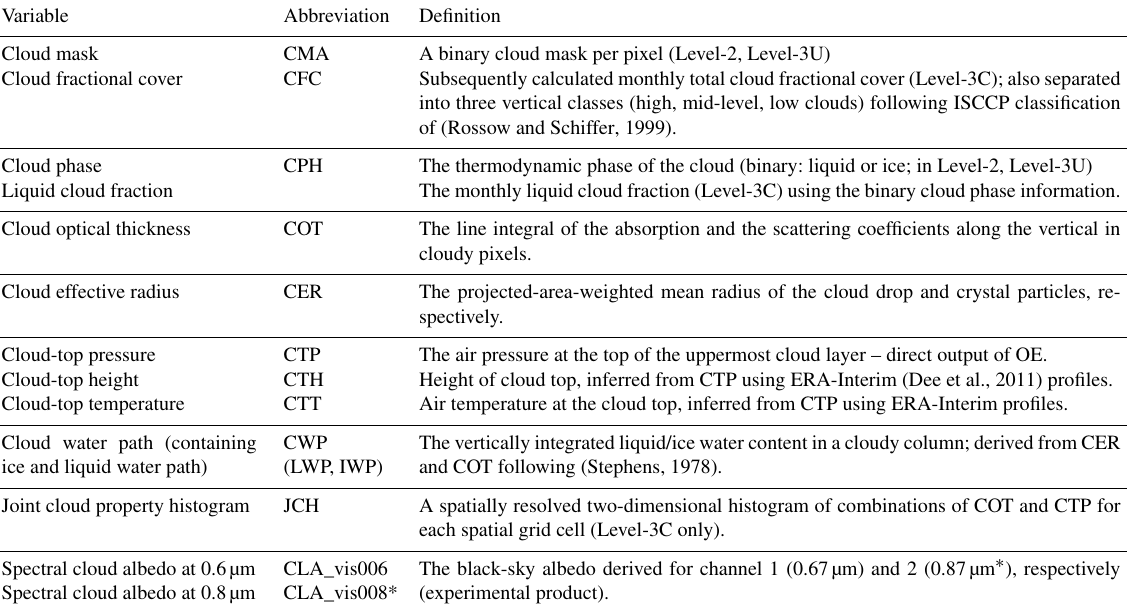
Table 2. List of generated cloud properties. See Sect. 2.4 for more information on the processing levels Level-2, Level-3U and Level-3C. Variable